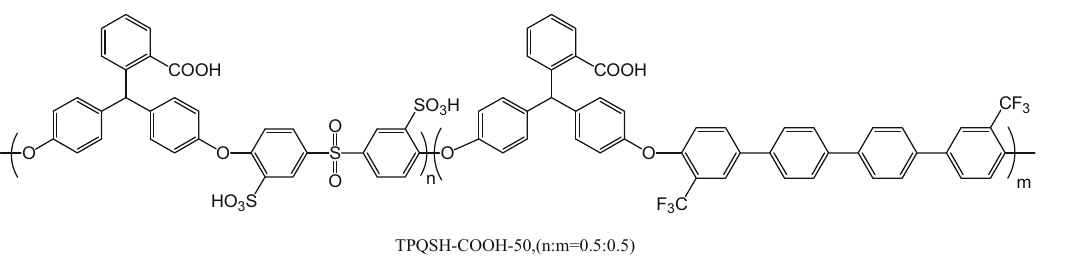
Figure 2: Chemical structure of the pristine copolymer TPQSH - COOH - 50 ( 44 )